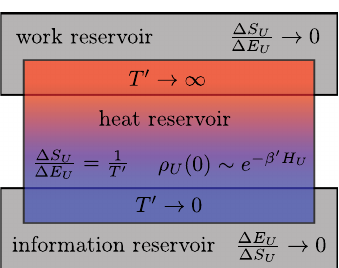
FIG. 3. Venn diagram of the thermodynamic role of the stream of units. In general, the interaction can be arbitrary, but if the initial state of the units is thermal, they can mimic an ideal heat reservoir when they fulfill the Clausius equality (55). In the limiting case where T 0 → ∞ , we obtain a work reservoir (Sec. IV B). The converse is not true; i.e., not every work reservoir can be obtained as a limiting case of a heat reservoir. Similarly, we can obtain an information reservoir (Sec. IV C) out of a heat reservoir for T 0 → 0 , but again the converse is not true. We note that some setups do not fit in any of the three